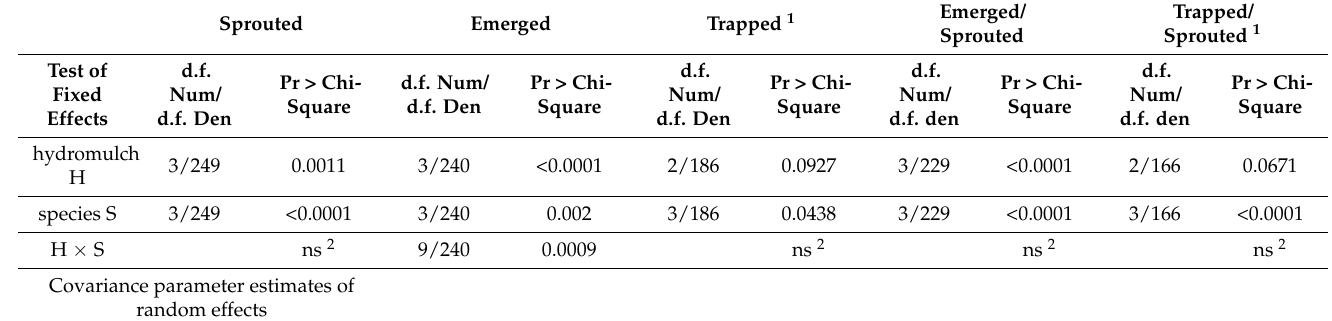
Table 2. Likelihood ratio statistics of fixed effects ‘hydromulch’, ‘species’, and ‘hydromulch × species’, covariance parameter estimates of the random effects, and model fit statistics in the analyses of proportions of sprouted rhizomes (SPROUTED), of rhizomes that produced emerged shoots (EMERGED), of rhizomes that produced shoots trapped under the hydromulch (TRAPPED), of sprouted rhizomes whose shoot/s emerged (EMERGED/SPROUTED), and of sprouted rhizomes whose shoots were all trapped under the hydromulch (TRAPPED/SPROUTED), all of them according to generalized linear mixed models of binomial